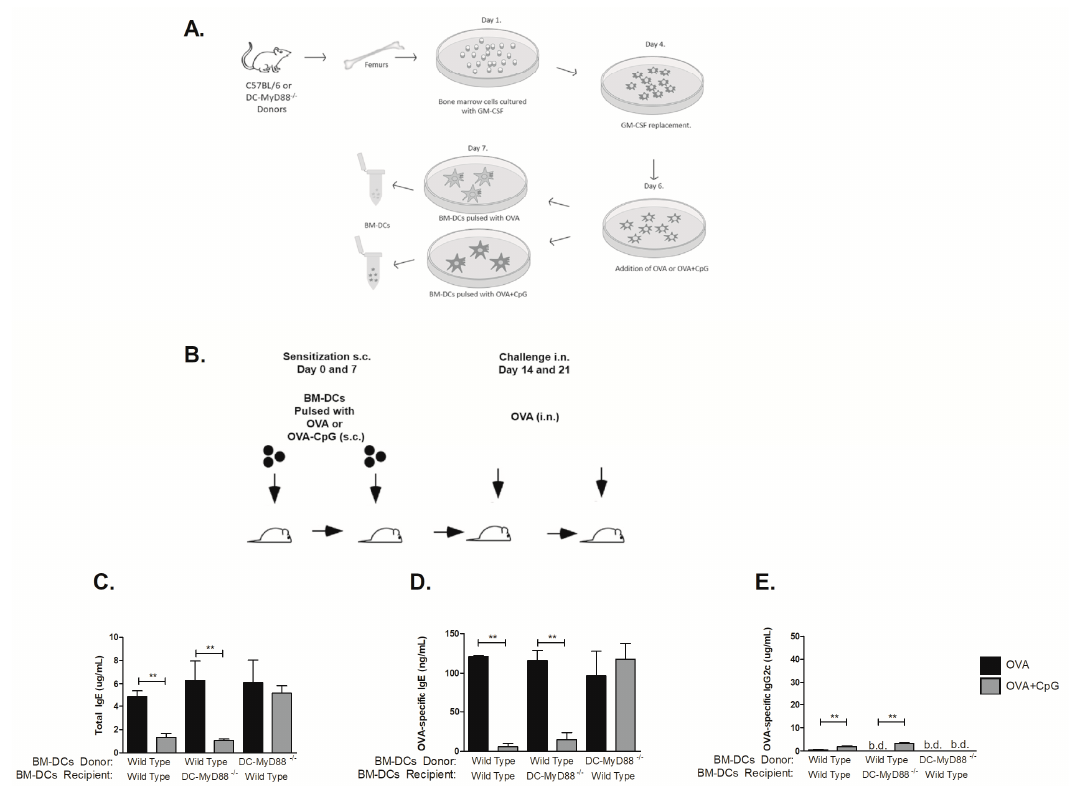
Figure 5. Myd88 expression on CD11c-positive dendritic cells is essential for CpG-induced suppression of IgE production. Bone marrow-derived dendritic cells (BM-DCs) obtained from C57BL / 6 wild type (WT) or mice lacking Myd88 on CD11c-positive dendritic cells (DC-MyD88 − / − ) donors were pulsed with OVA or OVA plus CpG and injected subcutaneously on days 0 and 7 respectively to DC-MyD88 − / − or WT recipient mice. On days 14 and 21 recipient mice were challenged intranasally with OVA Experiments were performed on day 22. ( A ) Schematic protocol for bone marrow derived dendritic cells (BM-DCs), ( B ) Experimental protocol. Serum levels of ( C ) Total IgE, (D) OVA-specific IgE or (E) OVA-specific IgG2c. OVA groups ( n = 5) and OVA + CpG groups ( n = 5). Values represent the mean ± SD and are representative of two independent experiments. b.d.—bellow detection level and One-way ANOVA: *** p < 0.001, di ff erent from respective OVA